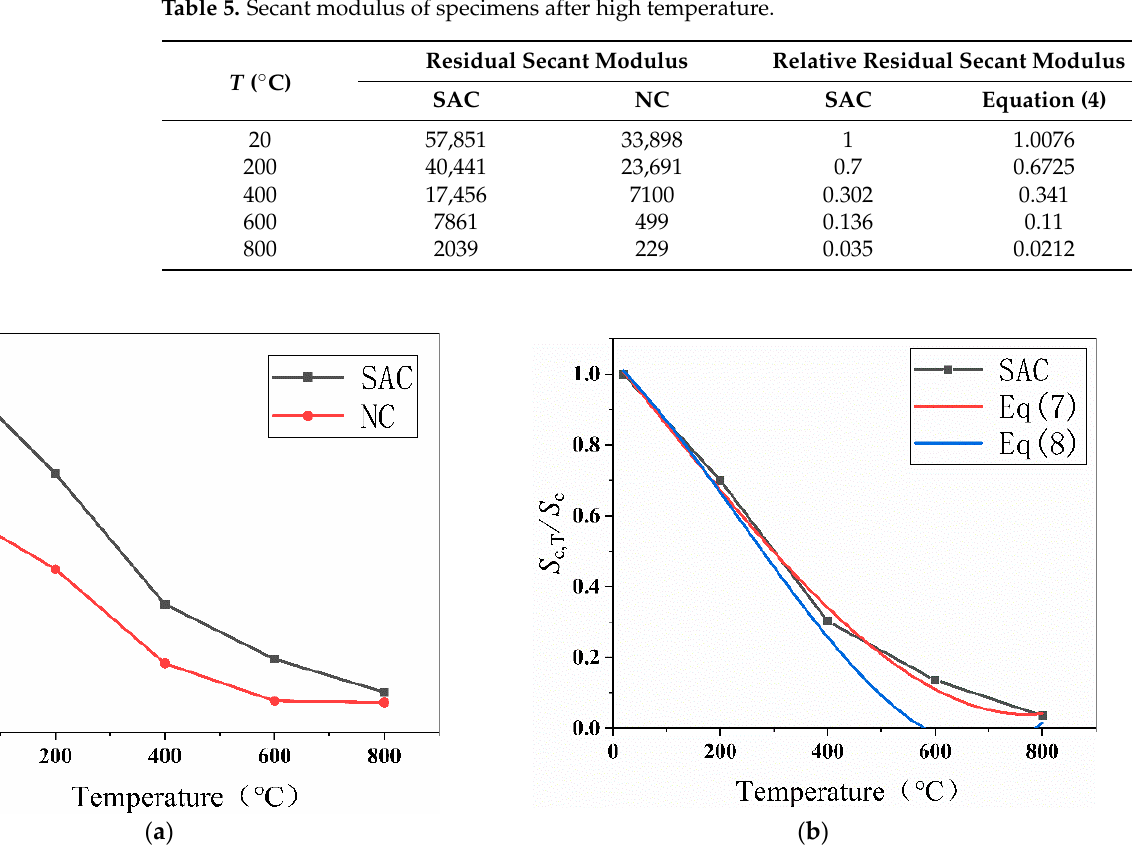
Figure 10. Secant modulus of specimens after high temperature: ( a ) Residual secant modulus. ( b ) Relative residual secant modulus.